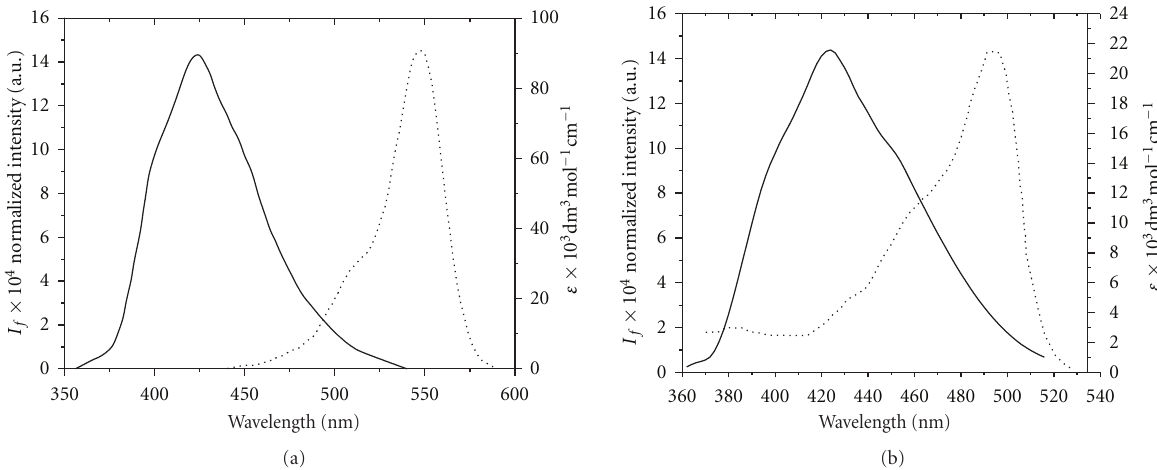
Figure 7: (a) Normalized emission spectrum of 1 × 10 − 5 moldm − 3 of POPOP (—) and absorption spectrum ( ··· ) of 1 × 10 − 5 moldm − 3 of RB in methanol, (b) normalized emission spectrum of 1 × 10 − 5 mol dm − 3 of POPOP (—) and absorption spectrum ( · · · ) of 1 × 10 − 5 mol dm − 3 of fluorescine in methanol.